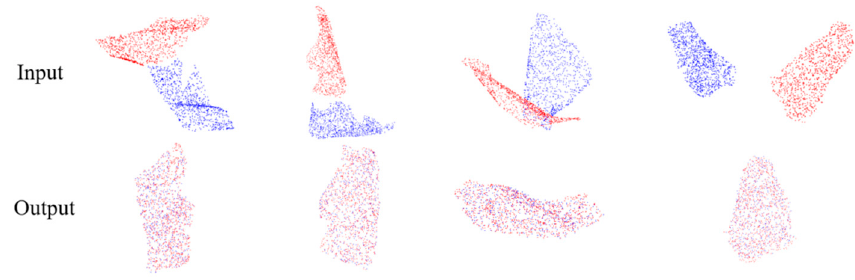
Figure 10. Registration visualization on several samples.